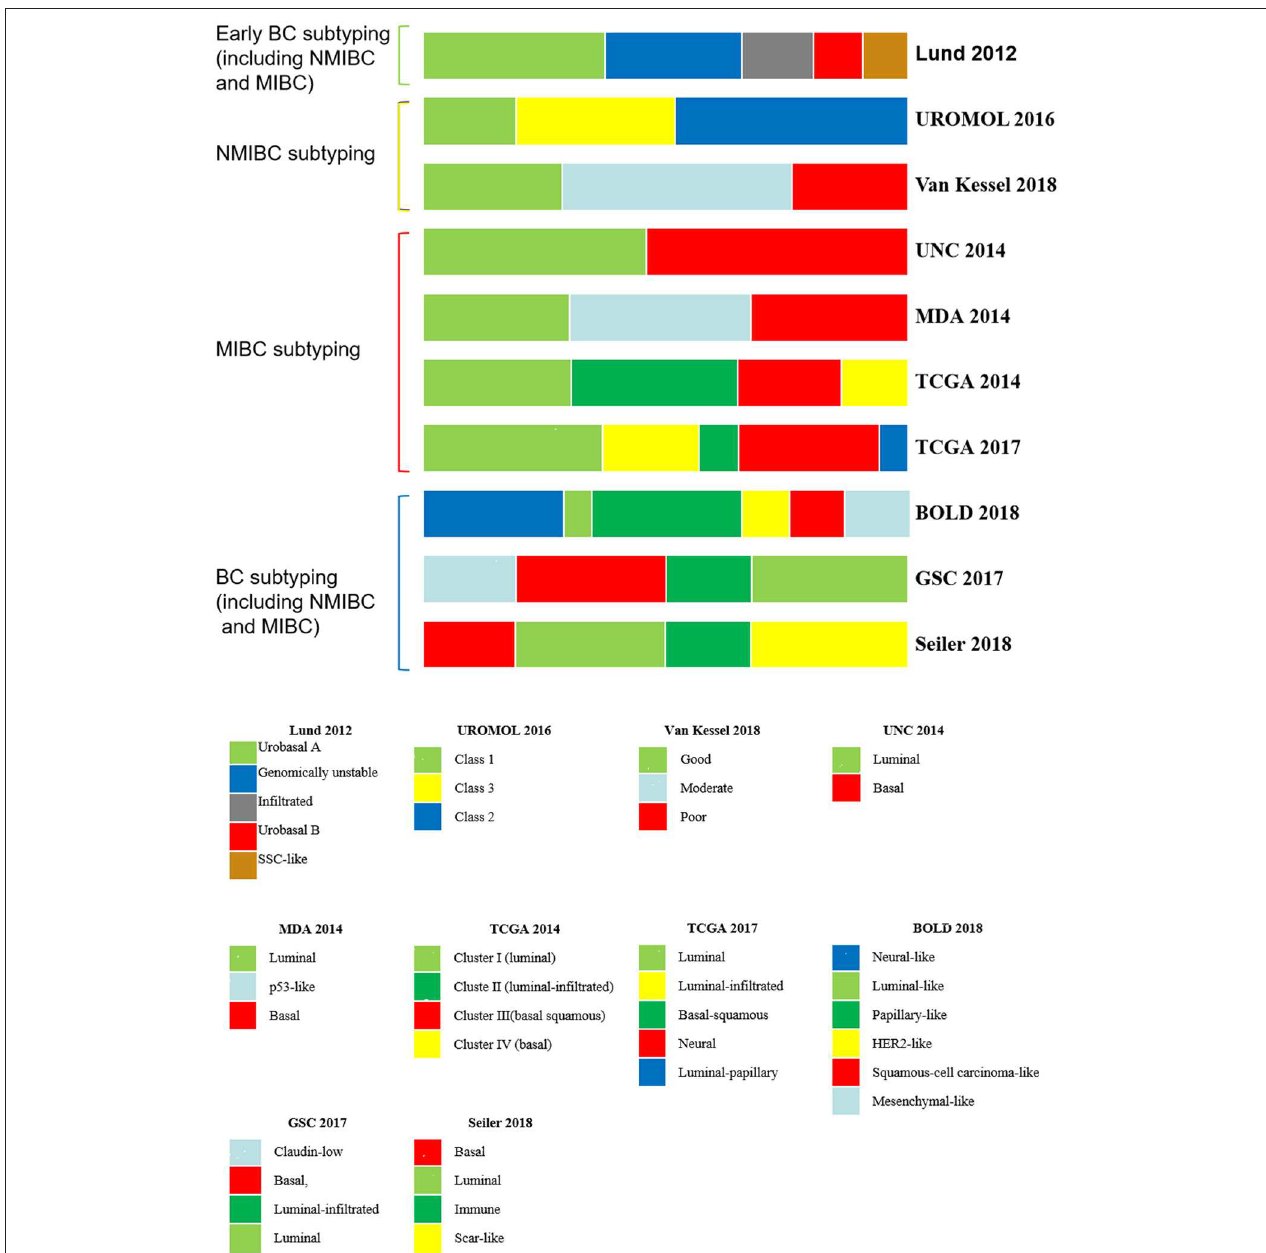
FIGURE 1 | BC molecular subtyping systems. BC, bladder cancer; NMIBC, non-muscular invasive bladder cancer; MIBC muscular invasive bladder cancer. The Class 1 subtype highly expresses early cell cycle-related genes, and the clinical prognosis is the best. The late cell cycle-related genes of the Class 2 subtype are highly expressed, and the clinical prognosis is poor. The Class 1 and Class 2 subtypes both highly expressed uroplakins, while Class 3 shows undifferentiation. In addition, by analyzing the genes of bladder cancer stem cell markers, it was found that Class 3 is enriched in stem cells and the basal cell marker CD44 gene. Compared with Class 1 and Class 3, Class 2 is enriched in EMT (epithelial-mesenchymal transition)-related